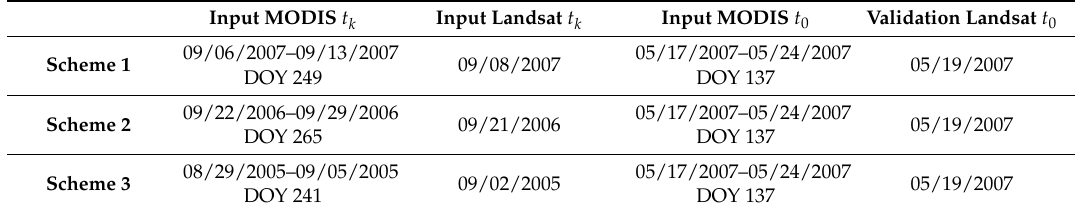
Table 2. Description of the input images used for the validation of the three schemes for data fusion.